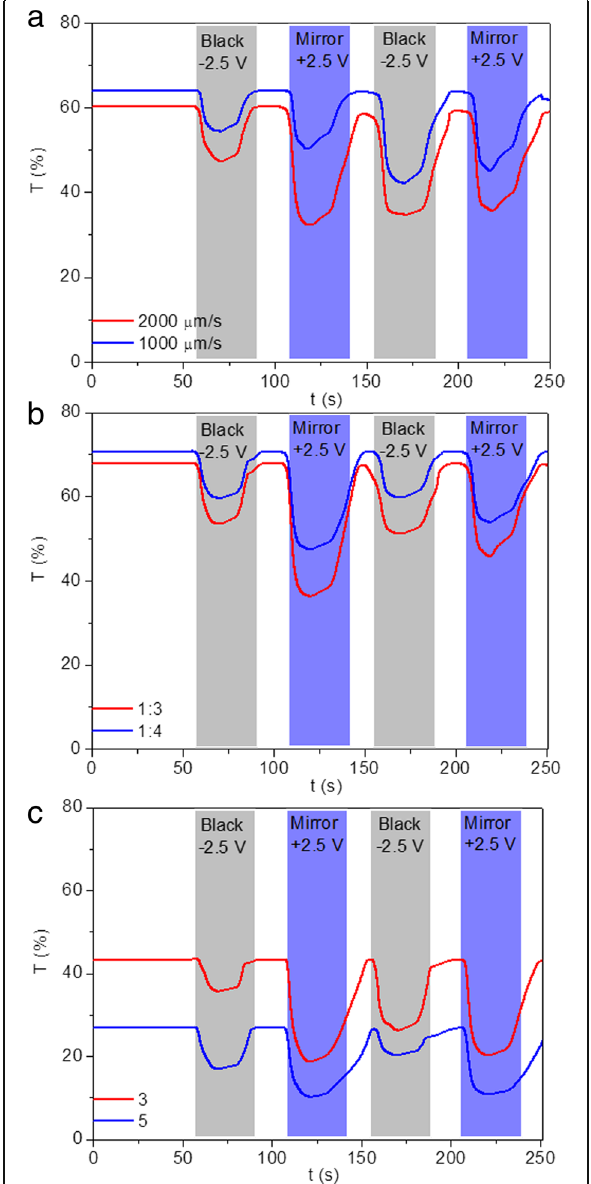
Fig. 9 (Color online) Transmittance variation of TiO 2 nanoparticles modified devices prepared under different modification conditions at 700 nm during two-electrode CV tests, including a different lifting speeds, b different precursor concentrations, and c different dipping